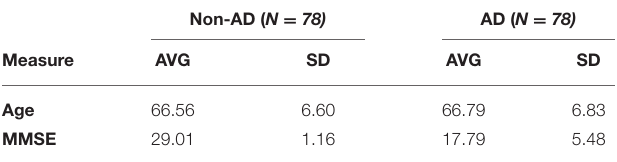
TABLE 2 | The average and SD of age and MMSE.